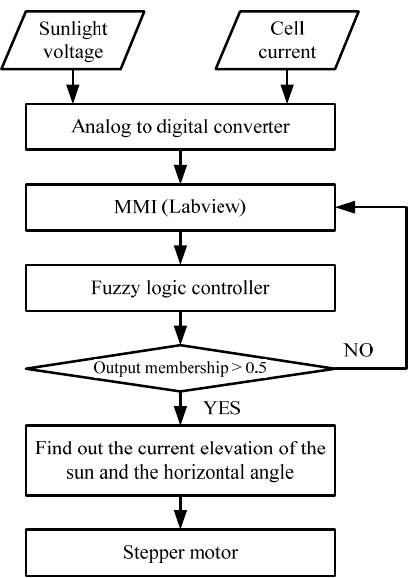
Figure 9. Flowchart of solar tracking system.